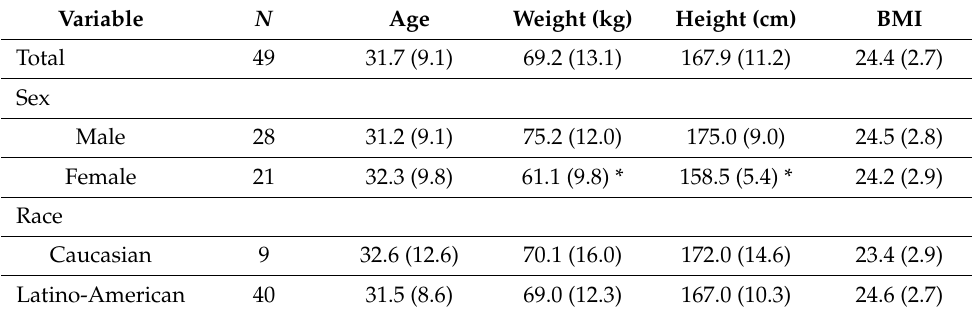
Table 2. Demographic characteristics of the subjects according to sex and race.